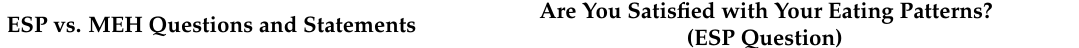
Table 16. The distribution of responses selected from the “My Eating Habits” questionnaire in accordance with the satisfac- tion with eating patterns in females.